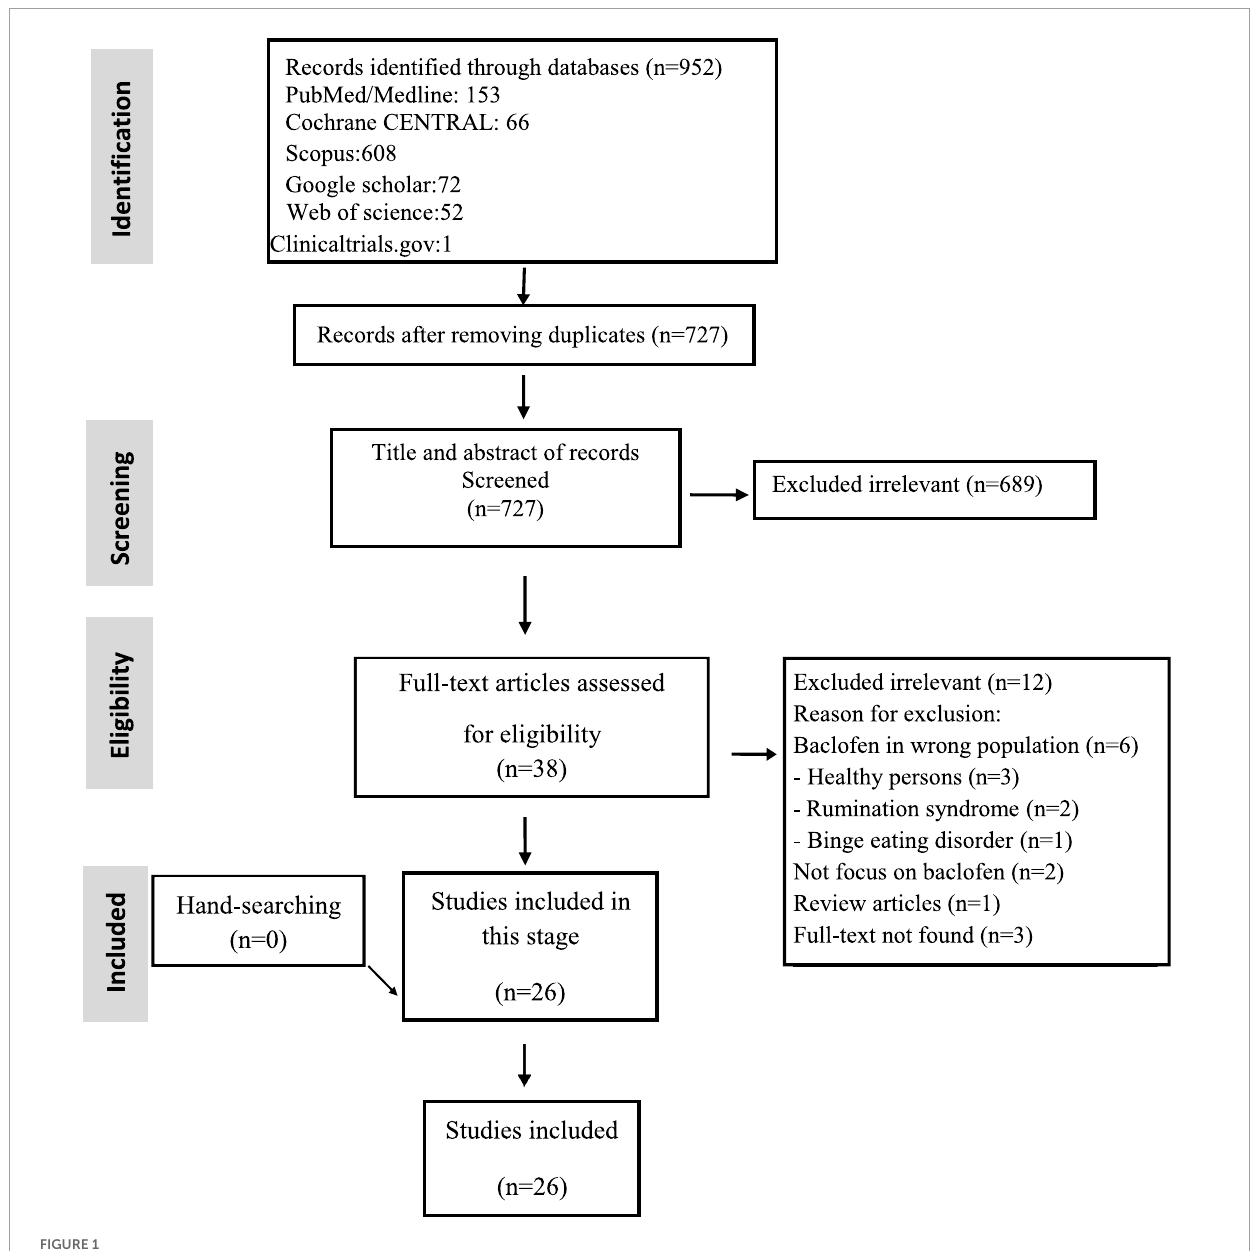
FIGURE1 Flow chart of study selection for inclusion in the systematic review and